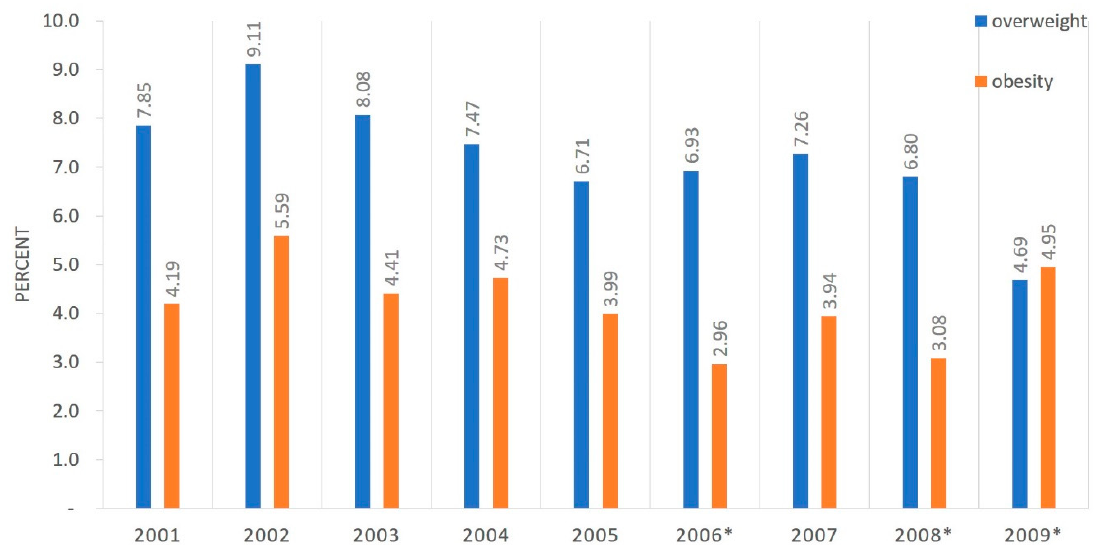
Figure 4. Prevalence of overweight and obesity in all children (boys and girls) at age 6–7 by birth year. (* 2006–2008: p = 0,0043; 2006–2009: p = 0,0026; 2008–2009: p =